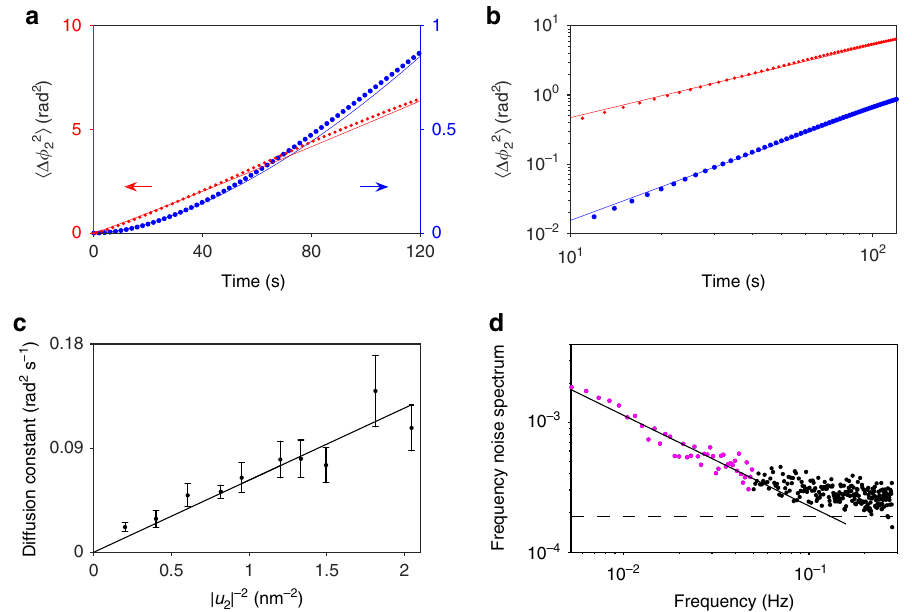
Figure 4 | Anomalous phase diffusion and intrinsic frequency noise. ( a ) When extra broadband noise is injected into the plate mode, the phase of the beam mode undergoes diffusion where the phase variance increases linearly with time (red). Without the extra noise, anomalous diffusion occurs as the time dependence becomes super-linear (blue). The error bar is smaller than the dot size. ( b ) Log-log plot of the same data. The slopes of linear fits (solid lines, also plotted in a ) yield power law exponents of 1.05 and 1.62 for ordinary and anomalous diffusion, respectively. ( c ) The dependence of the phase diffusion constant D in the presence of extra broadband noise on the inverse square oscillation amplitude. The line is a linear fit through the origin. Error bars represent ± 1 s.e. ( d ) Power spectrum of the frequency noise of the beam mode. A fit to the purple region yields a dependence of the form 1/ o 0.7 . The dashed line represents the minimum frequency noise that can be resolved, limited by noise in the detection